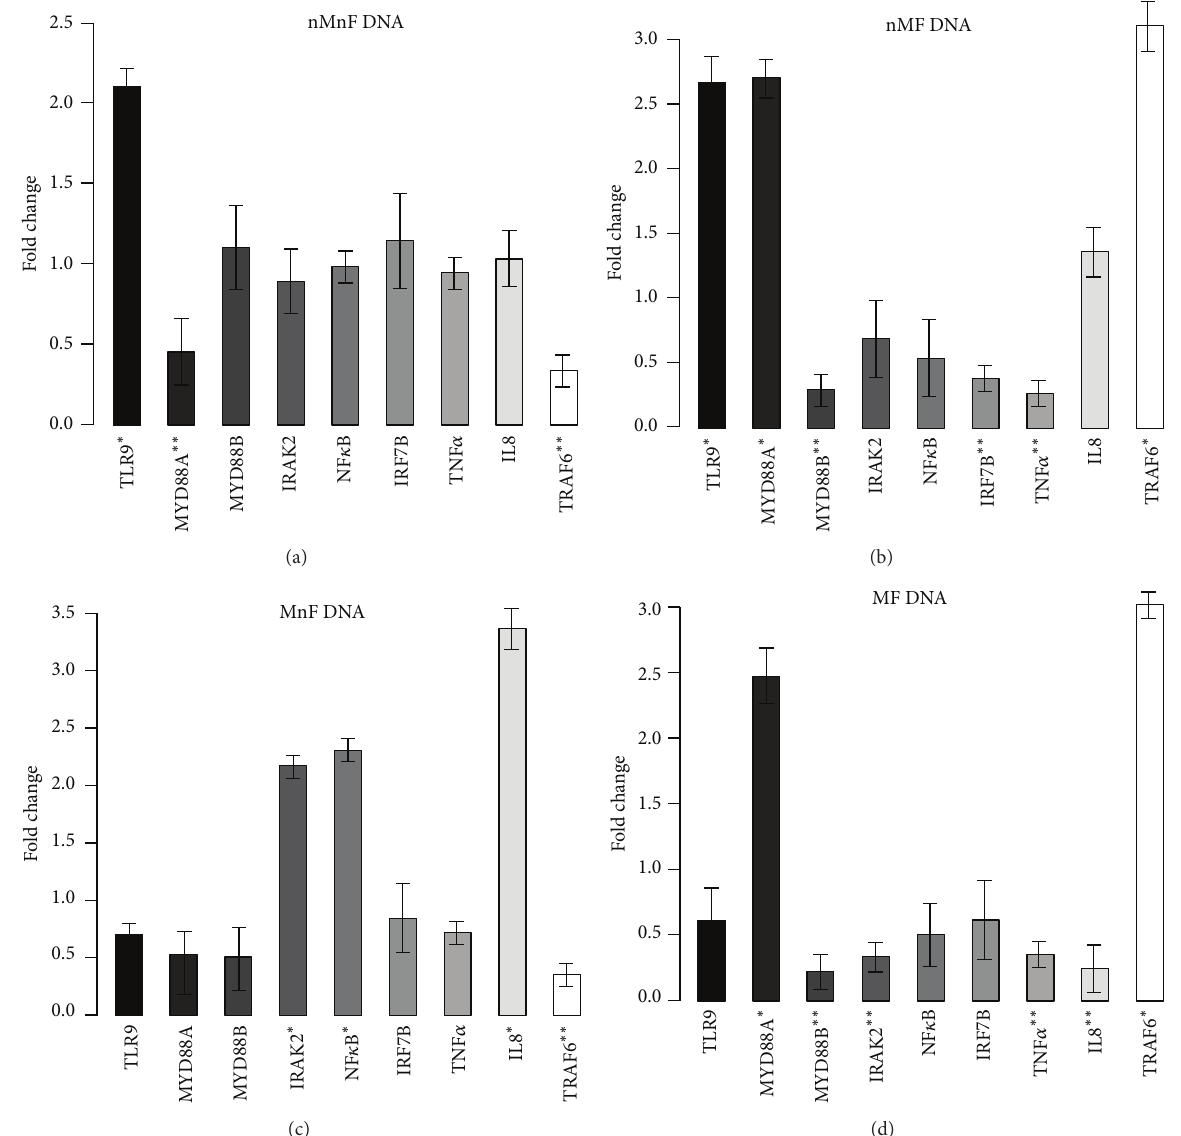
Figure 2: Expression fold changes of the assayed genes. (a) Incubation with normally methylated/nonfragmented DNA. TLR9 was overex- pressed, and MYD88A and TRAF6 were downregulated. (b) Incubation with normally methylated/fragmented DNA. TLR9, MYD88A, and TRAF6wereoverexpressed,andMYD88B,IRF7B,andTNF-alphaweredownregulated.(c)Incubationwithhypermethylated/nonfragmented DNA. NF 𝜅 B, IRAK2, and IL8 were overexpressed and TRAF6 was downregulated. (d) Incubation with hypermethylated/fragmented DNA. MYD88A and TRAF6 were overexpressed, and MYD88B, IRAK2, and IL8 and TNF-alpha showed downregulation. 18S was used as a housekeeping gene. Genes with > 2 expression fold changes are marked with ∗ ; the ones with < 0.5-fold change are marked with ∗∗